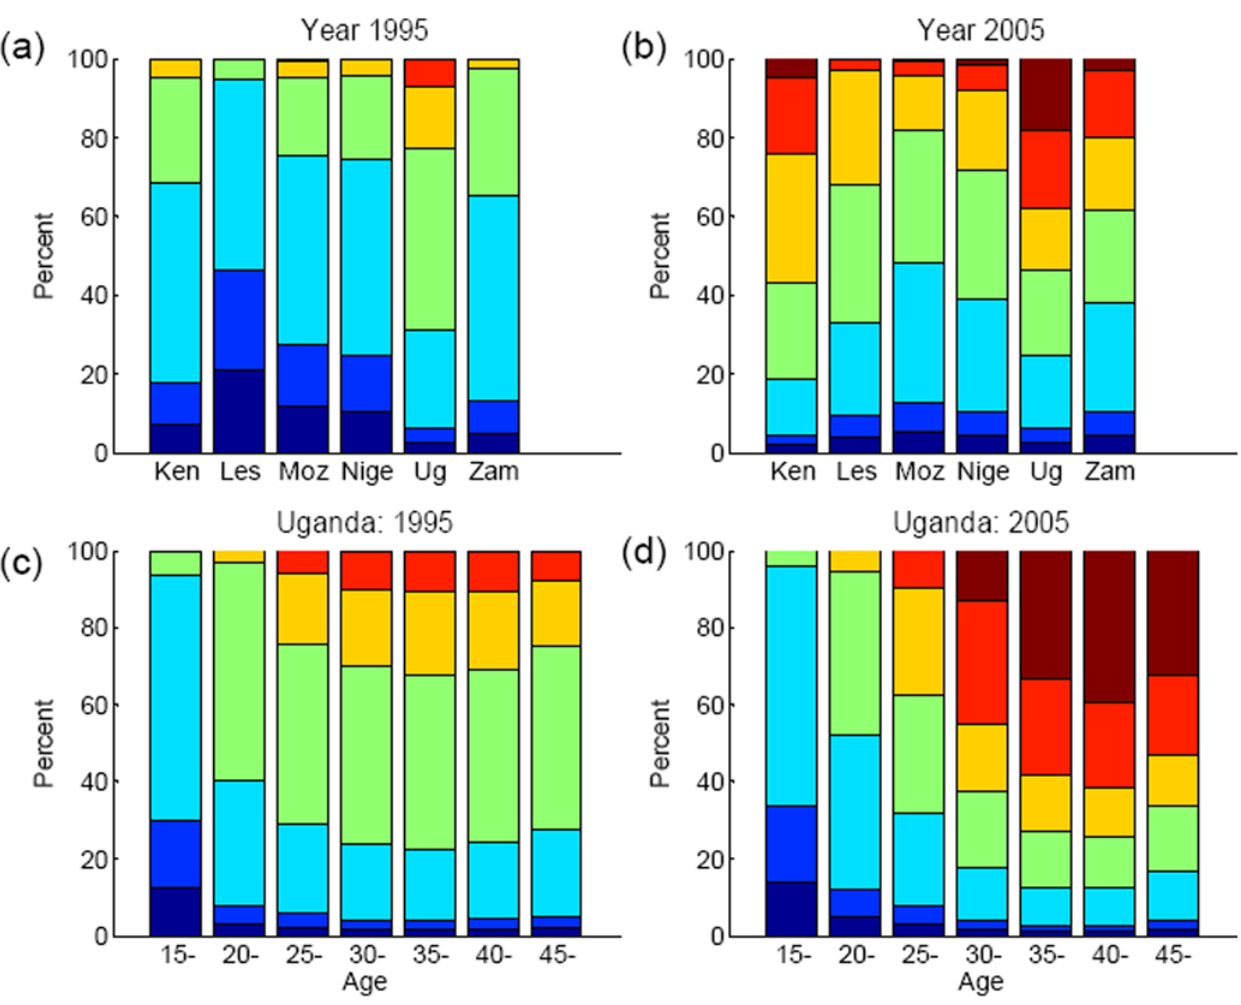
Figure 2. Distributions of time-since-infection for the HIV-infected populations across six African countries (Kenya, Lesotho, Mozambique, Nigeria, Uganda and Zambia) in (a) 1995 and (b) 2005; and across age-groups in Uganda in (c) 1995 and (d) 2005. Categories are (from base upwards): , 4months (dark blue); , 1 y (light blue); , 4 y (cyan); , 8 y (green); , 12 y (yellow); , 16 y(orange); 16 + y (dark red).